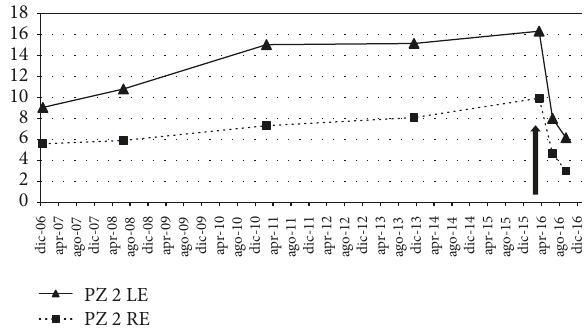
Figure 4: Ten-year trend of the Pattern Standard Deviation (PSD), from December 2006 to September 2016. The arrow indicates the beginning of treatment with CBS eye drop. RE: right eye; LE: left